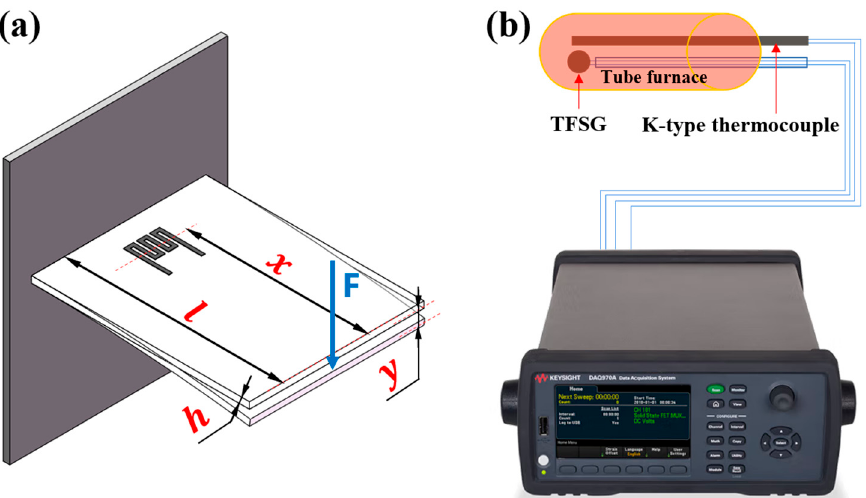
Figure 2. Schematic of experiment setups for ( a ) strain response testing and ( b ) temperature resistance characteristics testing.